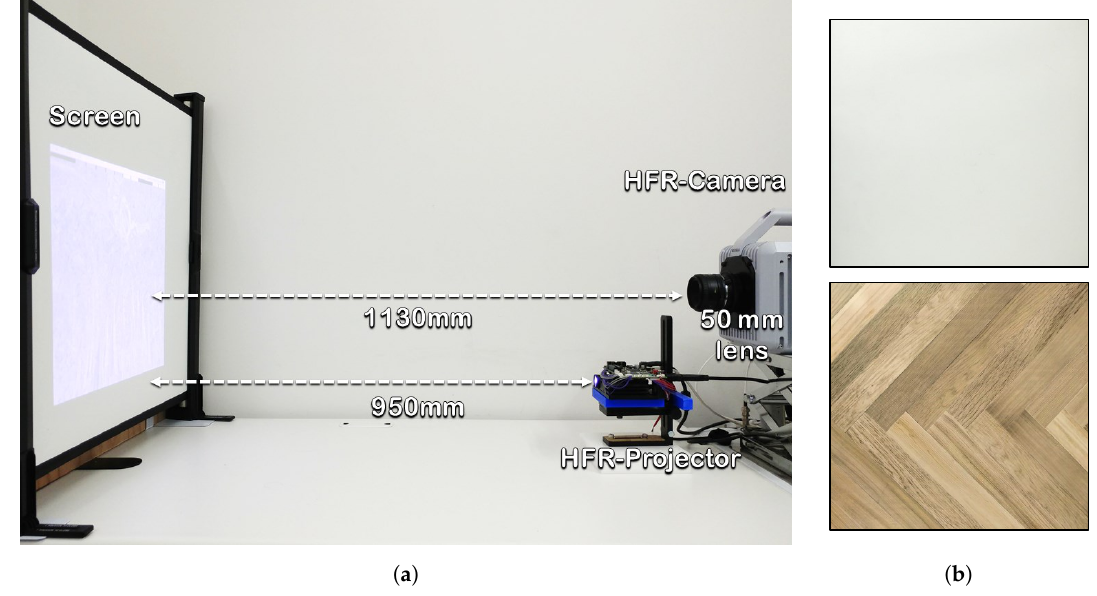
Figure 9. ( a ) overview of the HFR projector–camera system; ( b ) plain and patterned